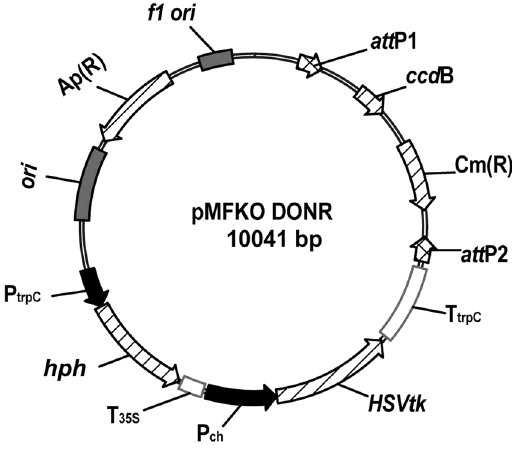
Figure 3. Schematic diagram of the vector pMFKO-DONR. f1 ori , phage f1 region; att P1 and att P2, Gateway sites; ccd B, coupled cell division B; Cm(R), chloramphenicol resistance gene; T trpC , terminator of trpC gene; HSVtk , thymidine kinase of herpes simplex virus; P ch , promoter region of Cochliobolus heterostrophus unknown protein presented in GenBank Accession Number M17304; T 35S , CaMV 3’UTR (polyA signal); hph , hygromycin B phosphotransferase gene; P trpC , promoter region of trpC gene. ori , ColE1 origin of replication; Ap(R), ampicillin resistance gene.